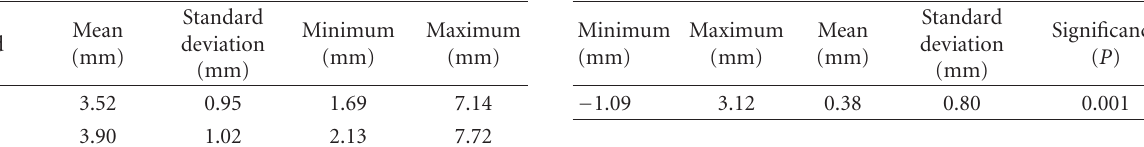
Table 2: Di ff erence among the nuchal fold thickness measurements by two- and three-dimensional